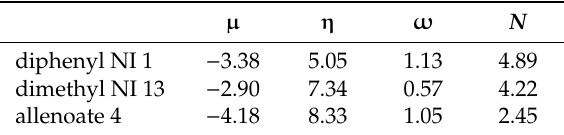
Table 1. MPWB1K/6-311G(d) global electronic chemical potential, μ , chemical hardness, η , electrophilicity, ω , and nucleophilicity, N , in eV, of NIs 1 and 13 , allenoate 4 .